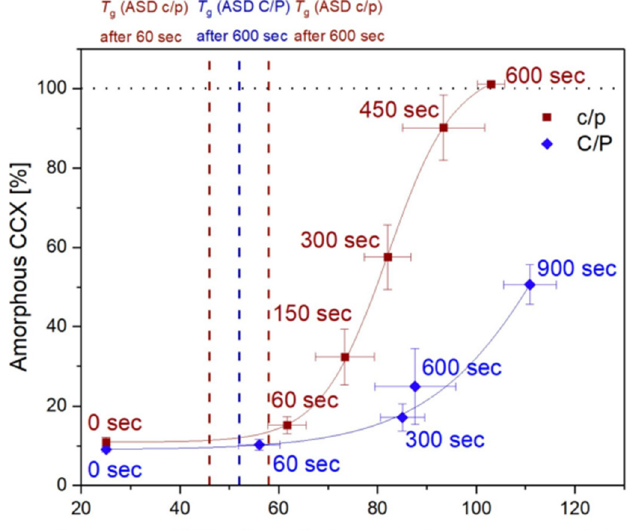
Figure 3. Degree of amorphization for the drug CCX plotted against the compact temperature obtained during microwaving at different exposure times. Two compacts containing CCX and the polymer PVP K12 with different particle sizes are shown, where c/p and C/P refer to small and large sizes of CCX/PVP, respectively. Mean ± SD ( n = 3). The dashed lines indicate different T g s. (Reproduced from [86] ).